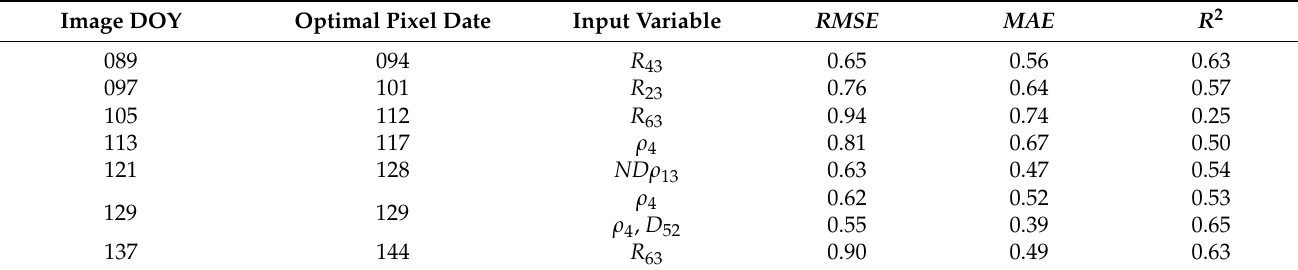
Table 5. Results of SOM prediction models for Arenosols based on seven